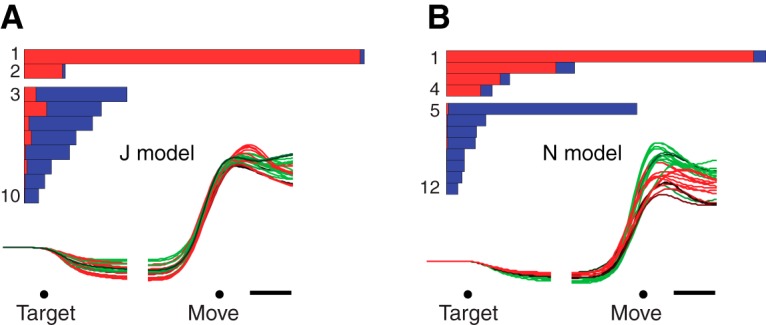
Same as Figure 3, but for the recurrent neural network models.